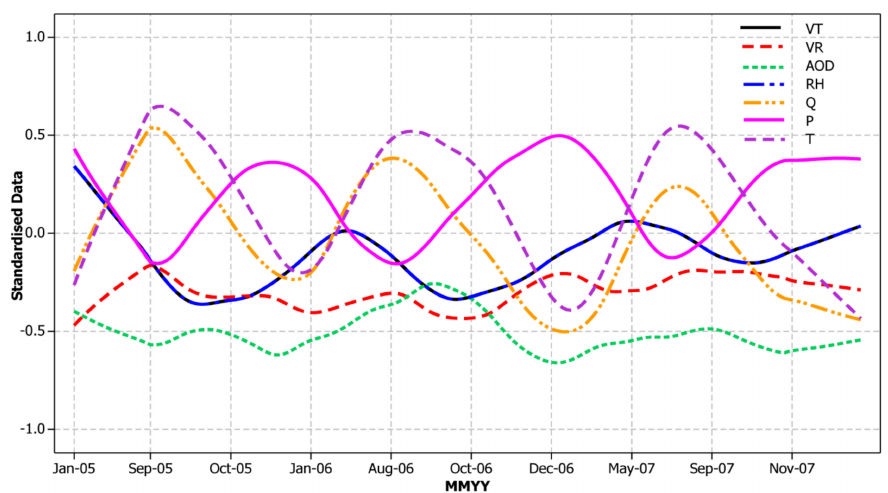
Figure 11. Line plot of smoothed and standardized VR, AOD, RH, VT, Q, P and T, where VT and RH are overlapping throughout the study period. NB. The x -axis shows only dates with available time-matched data, and thus is